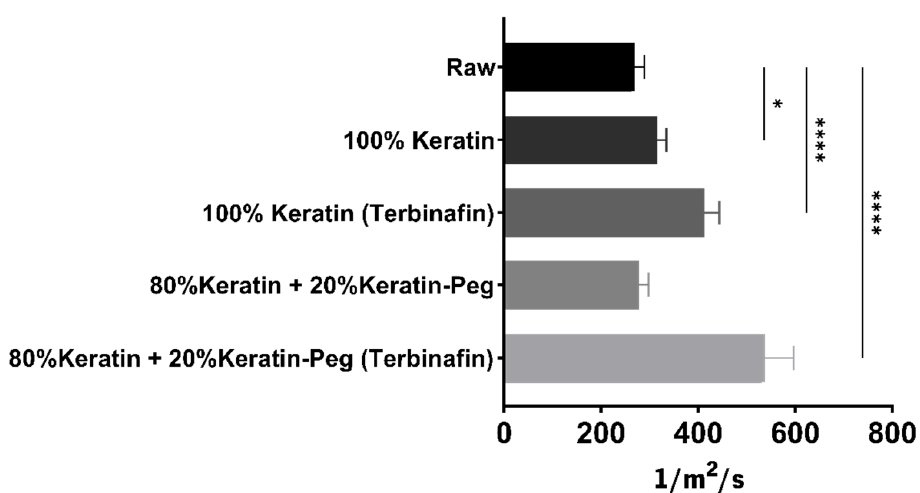
Figure 8. Air Permeability of functionalized fabrics with keratin particles (100% keratin; 100% keratin-Terb; 80% keratin/20% keratin-PEG; 80% keratin/20% keratin-PEG-Terb). The data were analyzed by Tukey’s multiple comparison test: the samples marked with * and **** represent significant differences ( p -value ≤ 0.05 (*) and p -value ≤ 0.0001 when compared with the raw sample).